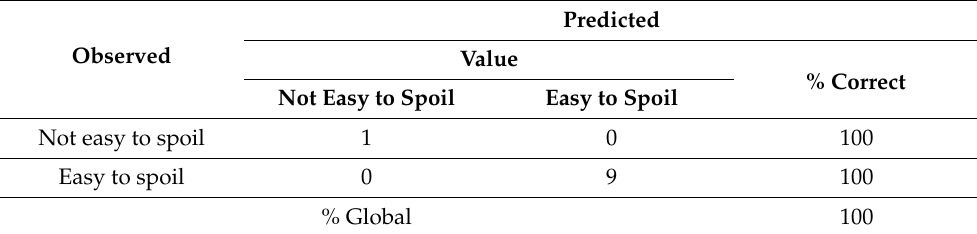
Table 4. Classification Table of the observed and predicted probabilities of the